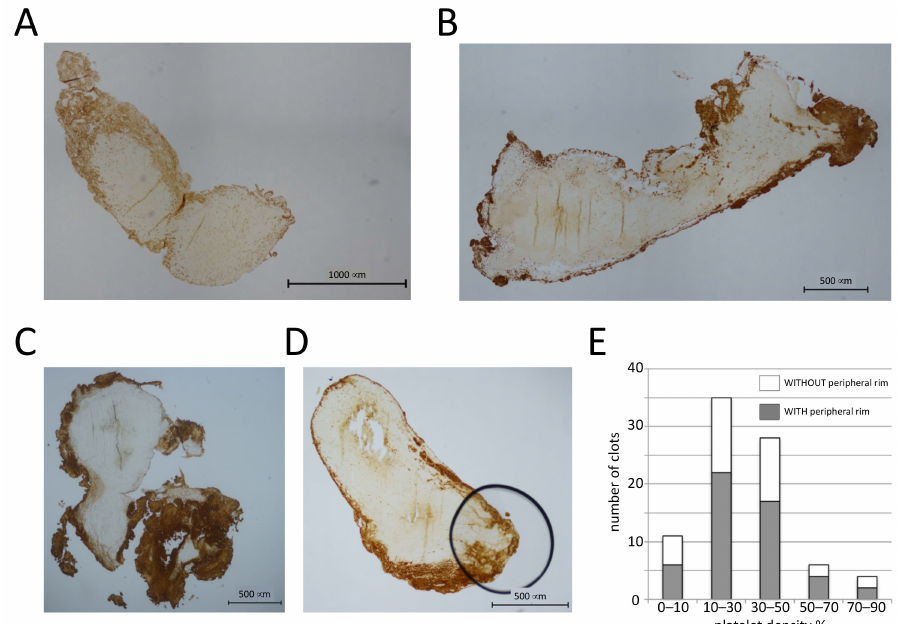
Figure 1. Platelets accumulate in the periphery of human coronary thrombi. ( A – D ) Sections (4 µ m) of human coronary thrombi stained with an antibody against CD42b. Four different examples of thrombi with a platelet-rich periphery are shown. ( E ) The surface area occupied by platelets was determined, and clots were classified into five different categories based on the platelet density. The number of clots with and without platelet accumulation in the periphery for each category is shown; n = 84